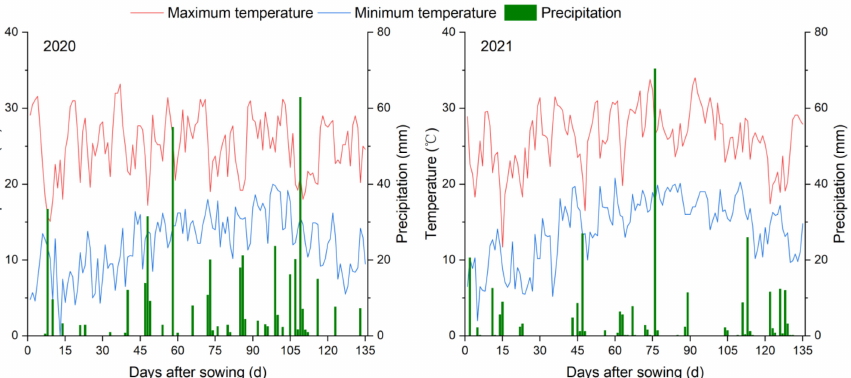
Figure 1. Meteorological data (maximum temperature, minimum temperature, and precipitation) for the 2020 and 2021 spring maize growing